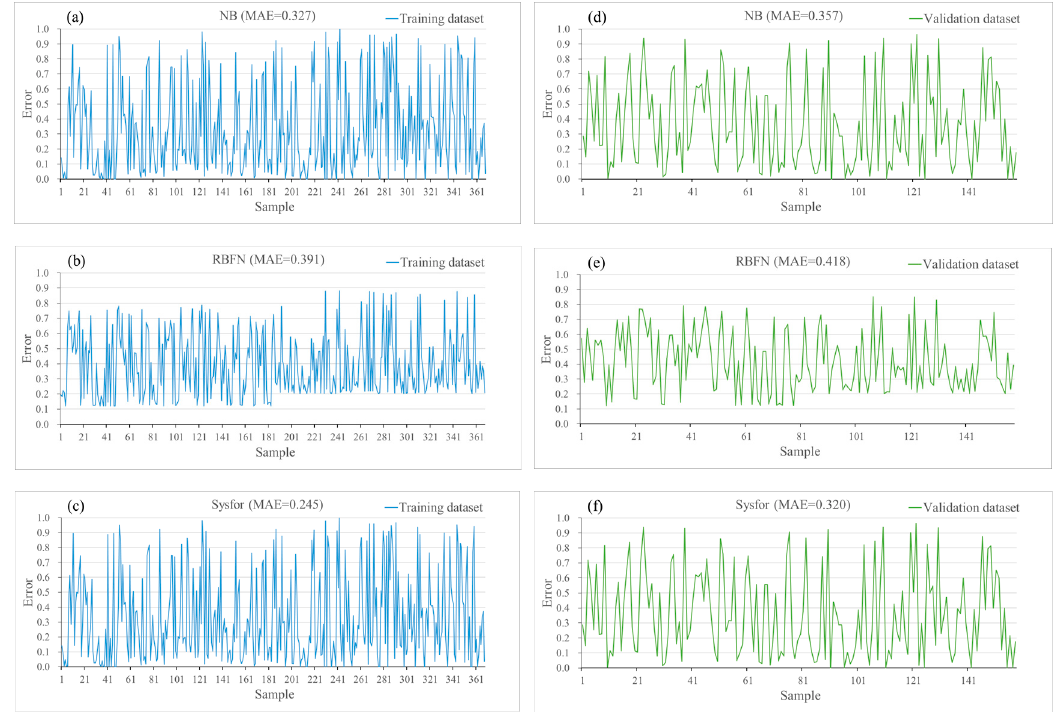
Figure 9. Modeling error in the training (a-c) and validation (d-f) datasets.